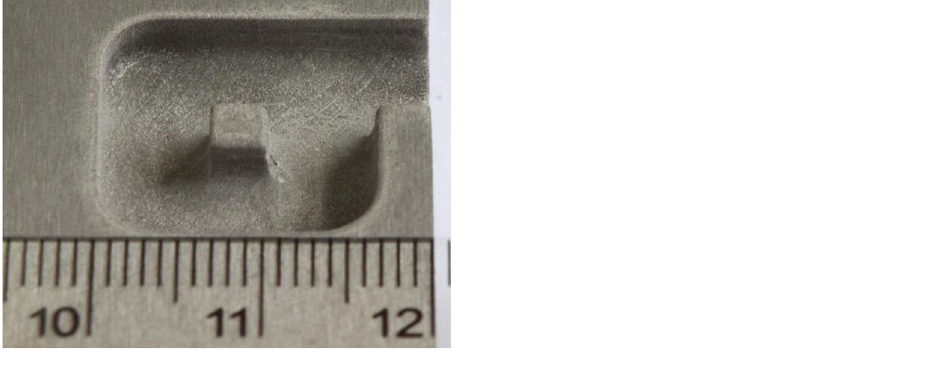
Figure 13. Photograph of machined